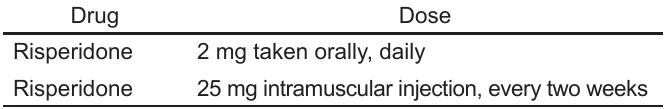
Table 4. Patient two outpatient medications prior to neuroleptic malignant syndrome